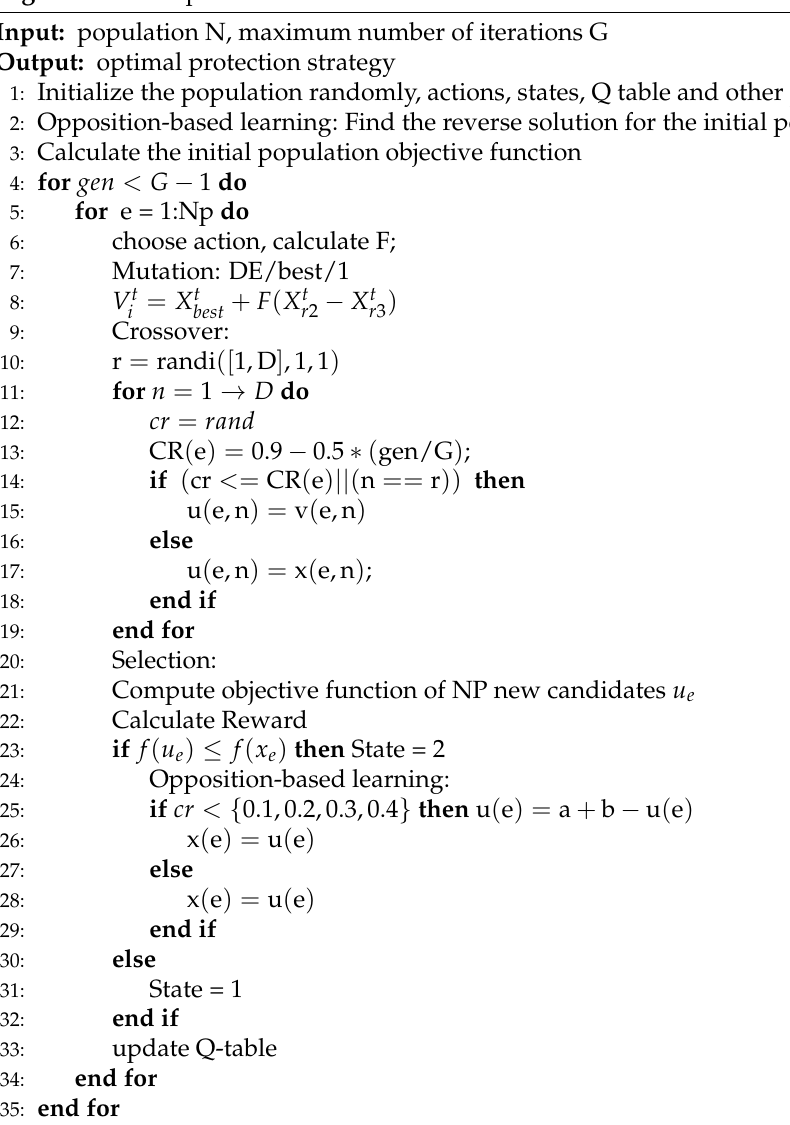
Algorithm 1 The pseudo of